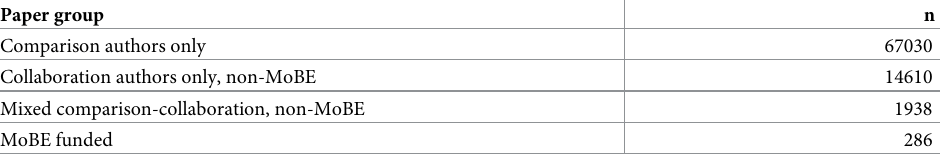
Table 2. Counts of papers in the analysis dataset, grouped by author type and whether they were funded by the MoBE program. Author groups are based only on authors included in either the collaboration or comparison set. For example, a non-MoBE paper by two collaboration authors and a third author (not included in either the collaboration set or the comparison set) would be counted as “collaboration authors